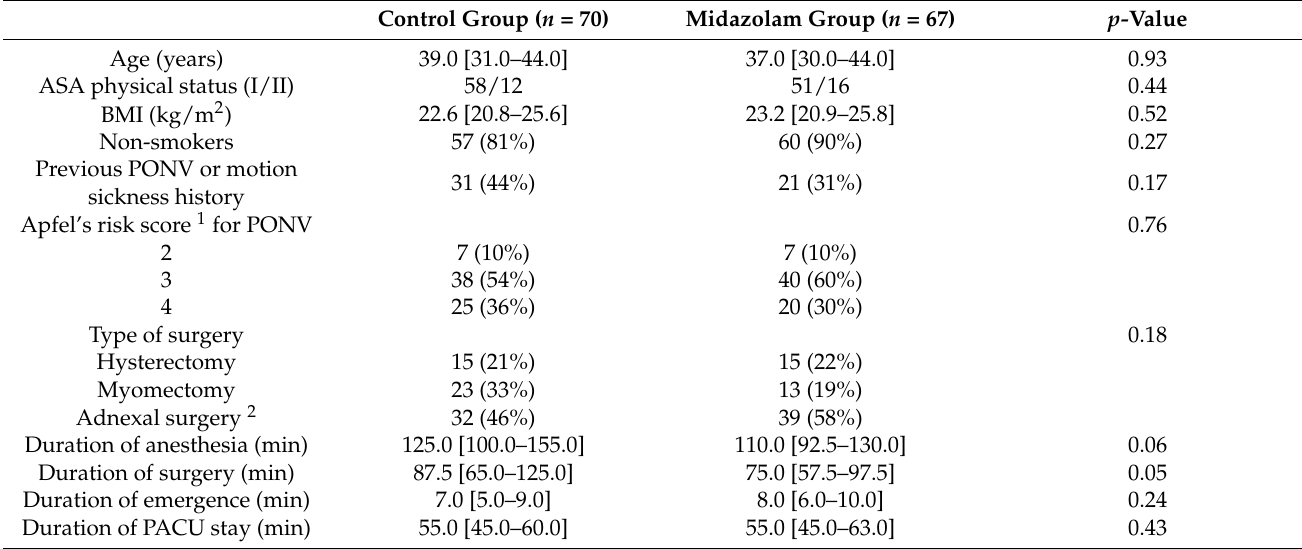
Table 1. Patient demographics and operative details.